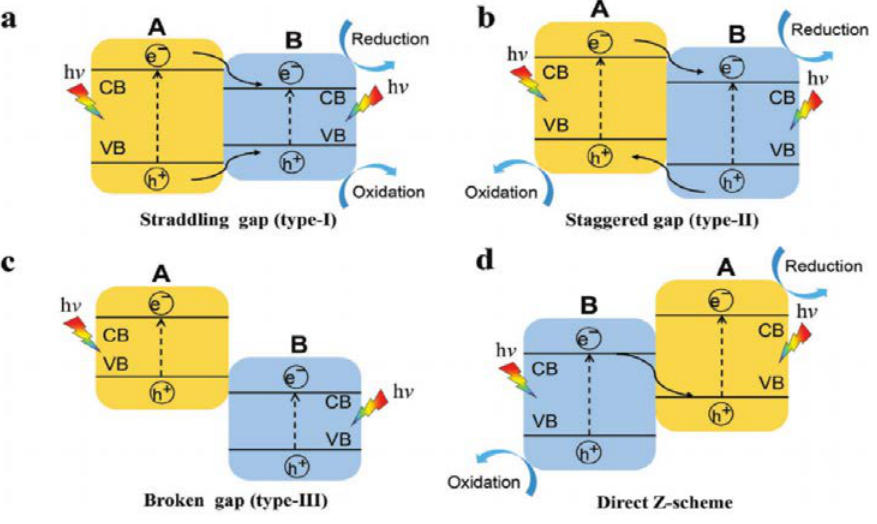
Figure 4. The electron–hole pairs’ migration under irradiation in various type of heterojunction pho- tocatalysts: ( a ) type-I, ( b ) type-II, ( c ) type-III, and ( d ) direct Z-scheme, adapted from [40].